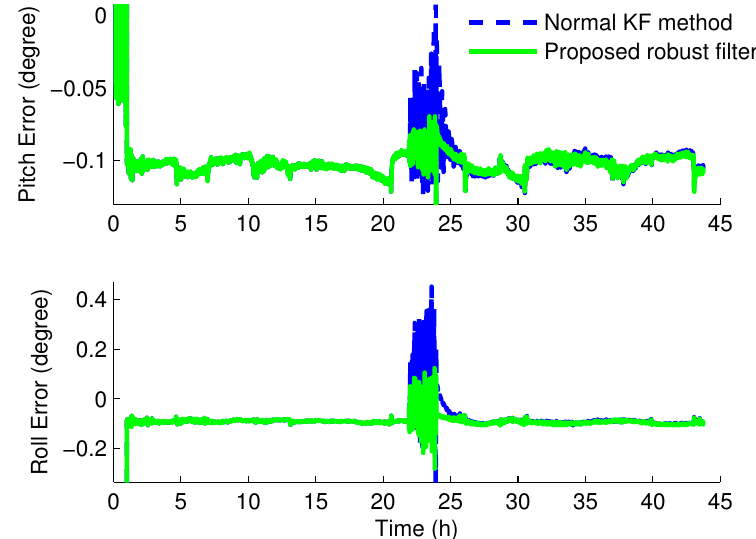
Figure 6. The horizontal angle errors with the normal Kalman filter method and the proposed robust H ∞ filter. The blue dash line indicates the horizontal errors by utilizing the normal Kalman filter method; The green solid line indicates the horizontal errors by utilizing the novel method proposed in this article.